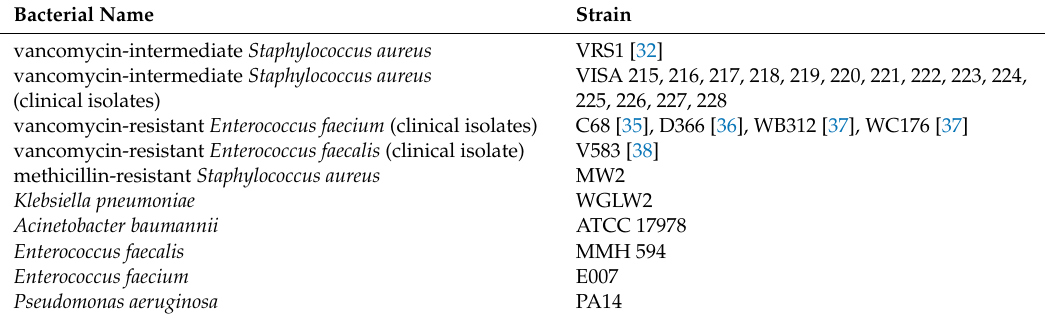
Table 4. Bacterial strains used in this